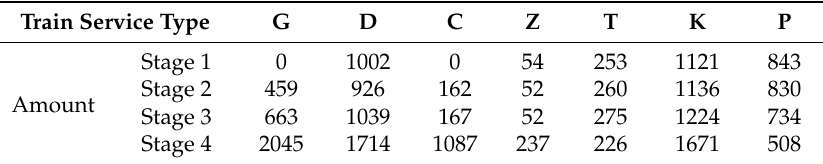
Table 4. Seven types of passenger train service.